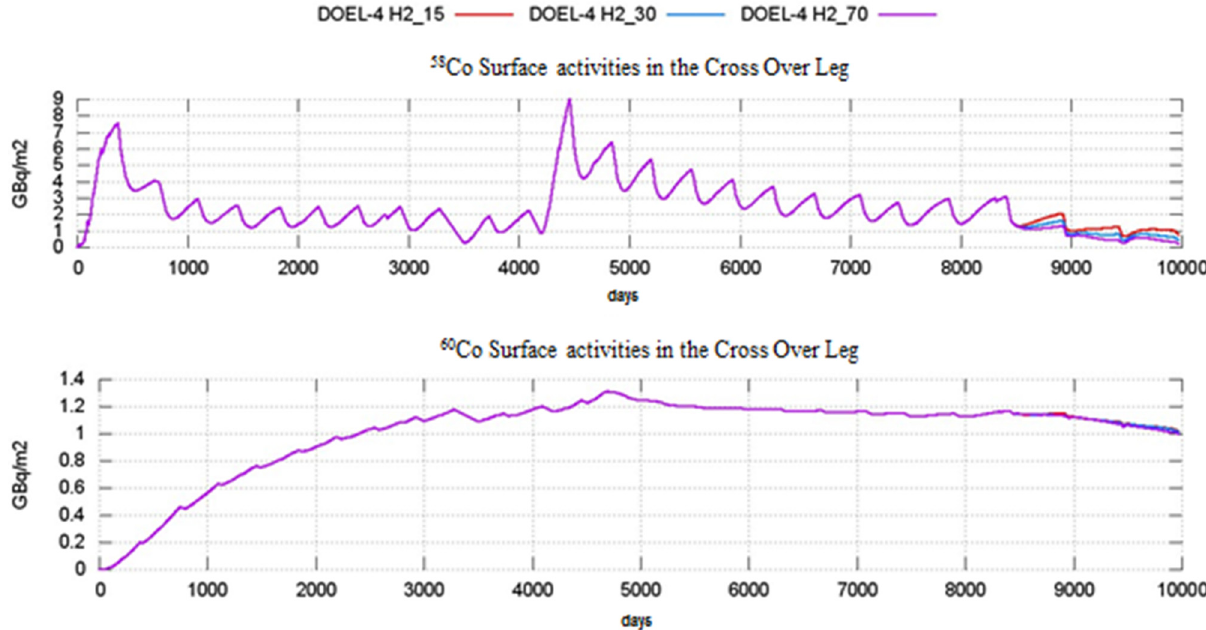
Fig. 5. OSCAR V1.3 calculation (cid:2) Surface activities in the crossover leg region of